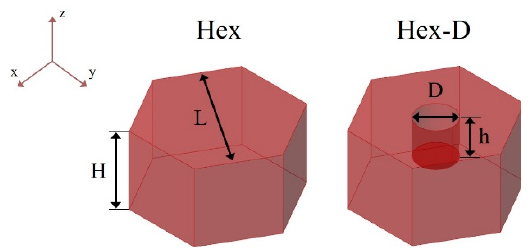
Figure 1. Different kinds of hexagonal prism tested for printing (z- is the build